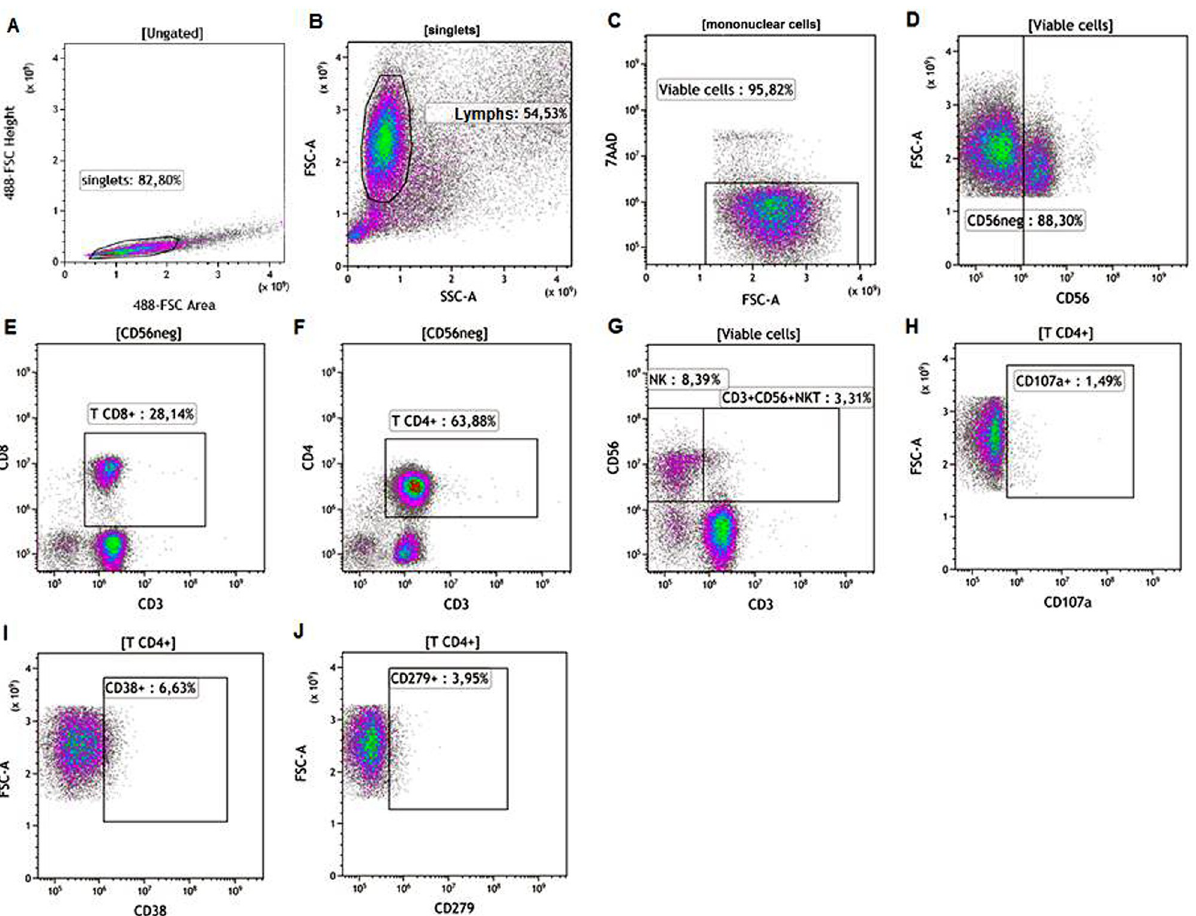
Fig 1. Flow cytometry representative protocol. A gate strategy was performed, as follow: ( A ) to exclude cell aggregates from analyses, cells were gated on singlets region in FSC-A vs . FSC-H dot-plot; ( B ) a second SSC-A vs . FSC-A dot plot was created from singlets gate and Lymphs region was defined; ( C ) Viable cells region were defined by a gate encompassing the 7AAD neg cells in a FSC-A vs . 7AAD dot-plot. ( D ) From Viable cells gate (7AAD neg ), CD56 neg cells were defined in CD56 vs . FSC-A dot-plot and from CD56 neg gate, (E) CD8 + T lymphocytes and (F) CD4 + T lymphocytes were determined; ( G ) CD3 vs . CD56 dot-plot, gated on Viable cells , was used to define NK and CD3 + CD56 + NKT cells. ( H-J ) From a gate on each cell population (exemplified here by CD4 + T cells), the frequencies of CD107a + , CD38 + and CD279 + cells were determined in respective dot-plots.